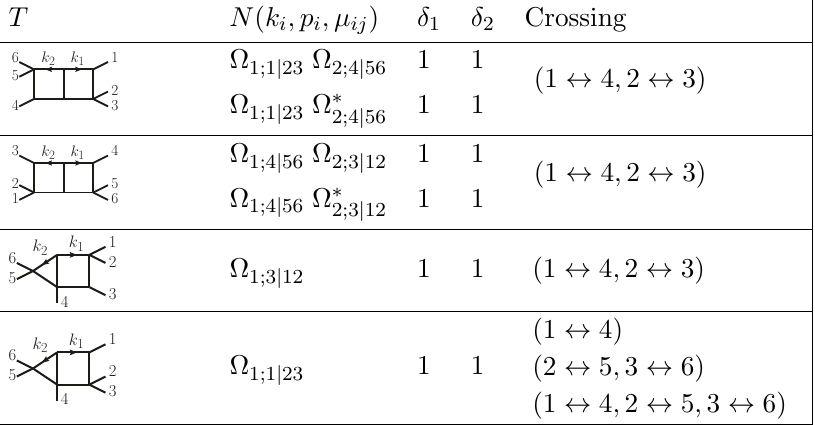
Table 2 . Master integral topologies made up of four external legs with local numerator insertions. The topology T and numerator N ( k i ; p i ; (cid:22) ij ) correspond to the integral de(cid:12)nition in eq. (4.3). Numerator building blocks (cid:9), (cid:8) and (cid:10) are de(cid:12)ned in eq. (4.6). (cid:14) 1 is the order at which the expansion of the master integral starts, while (cid:14) 2 the highest order in (cid:15) needed from the master integral for the amplitude